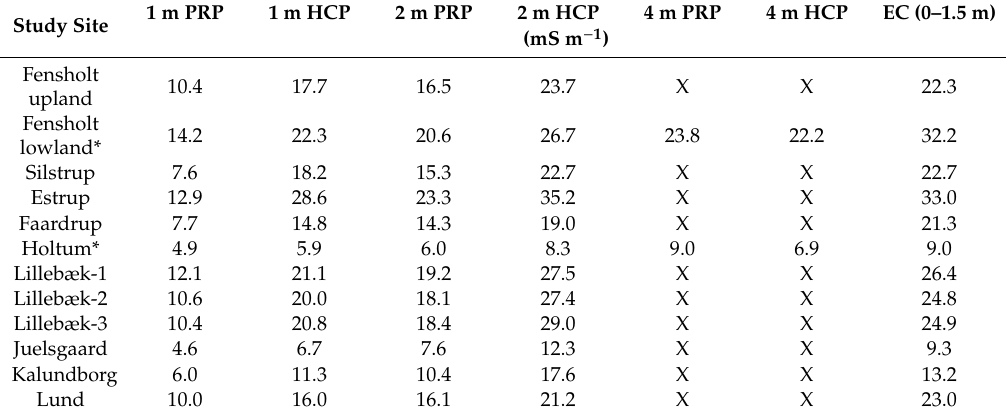
Table 3. Mean EC a measured by 1 m PRP (0–0.5 m), 1 m HCP (0–1.6 m), 2 m PRP (0–1 m), 2 m HCP (0–6.4 m), 4 m PRP (0–2 m), and 4 m HCP (0–6.4 m) coil configurations after removing the negative values and mean EC (0–1.5 m) estimates after data processing and